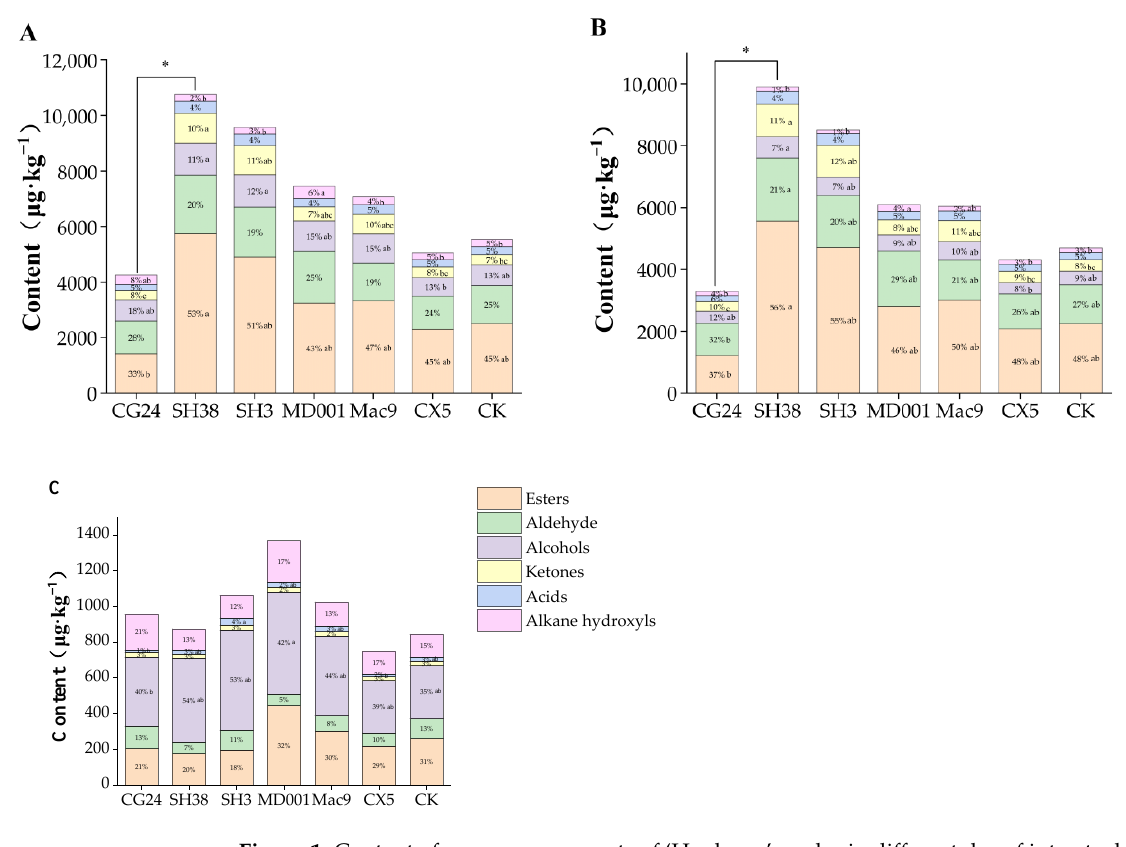
Figure 1. Content of aroma components of ‘Huahong’ apples in different dwarf interstock combina- tions. ( A ) Total aroma component content in skin and pulp. ( B ) Aroma component content in skin. ( C ) Aroma component content in pulp. Percentage represents relative content of each category in each combination. Values followed by the same letter within the same substances were not significantly different ( p < 0.05) according to Duncan’s assay significant difference test. * significant difference in total content between interstock combinations ( p < 0.05), Duncan’s assay.